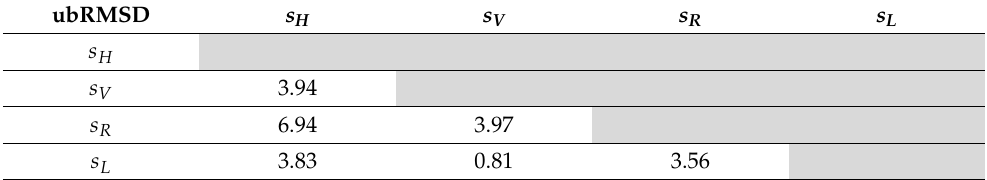
Table 4. The ubRMSD between GO modeled surface slope rms ( s ) using different polarizations. ubRMSD s H